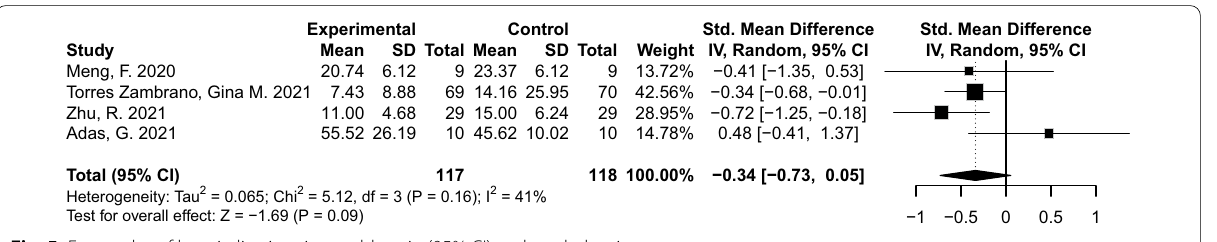
Total (95% CI) Heterogeneity: Tau 2 = 0.065; Chi 2 = 5.12, df = 3 (P = 0.16); I 2 = 41% Test for overall effect: Z = −1.69 (P = 0.09) Fig. 5 Forest plot of hospitalization time: odds ratio (95% CI) and pooled